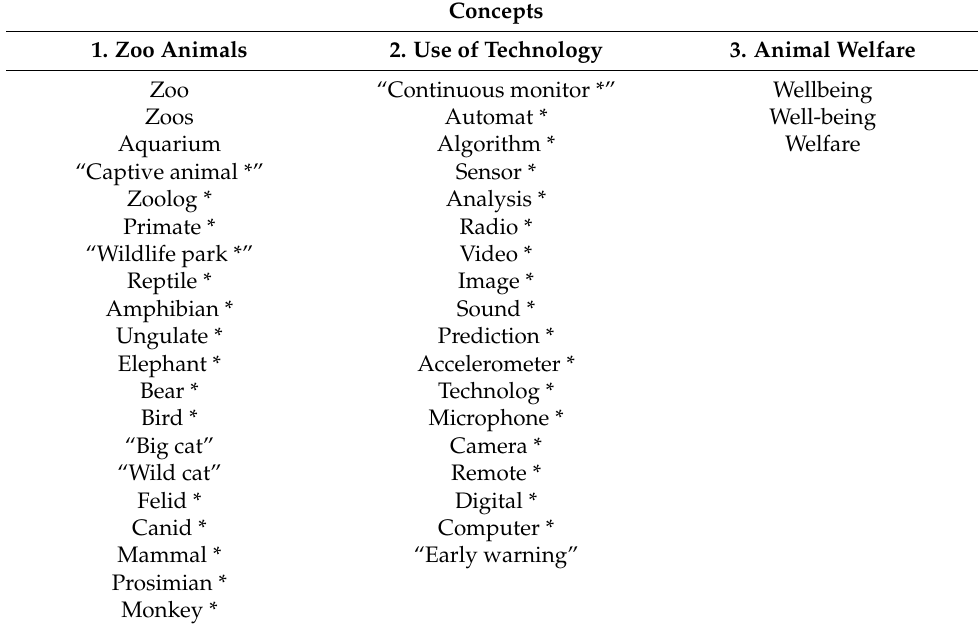
Table 1. The three concepts and the associated keywords used for the systematic literature